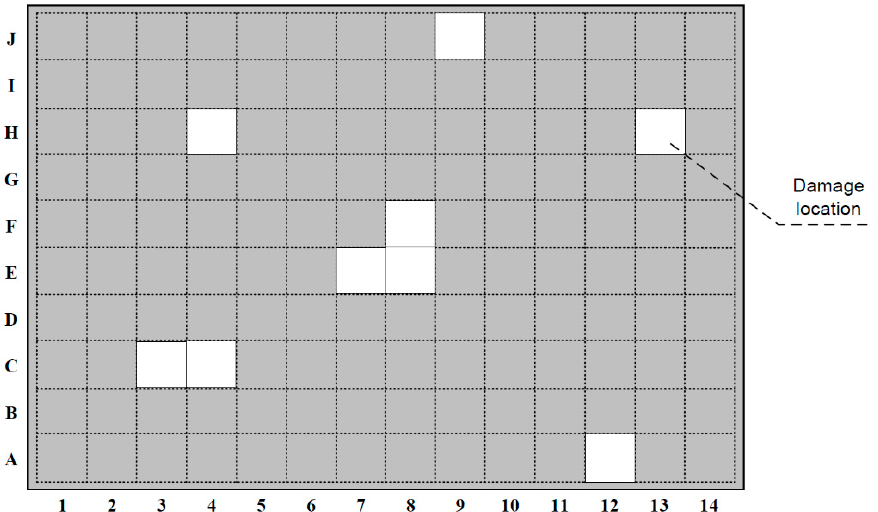
Figure 5. Discrete damage locations on the concrete plate.